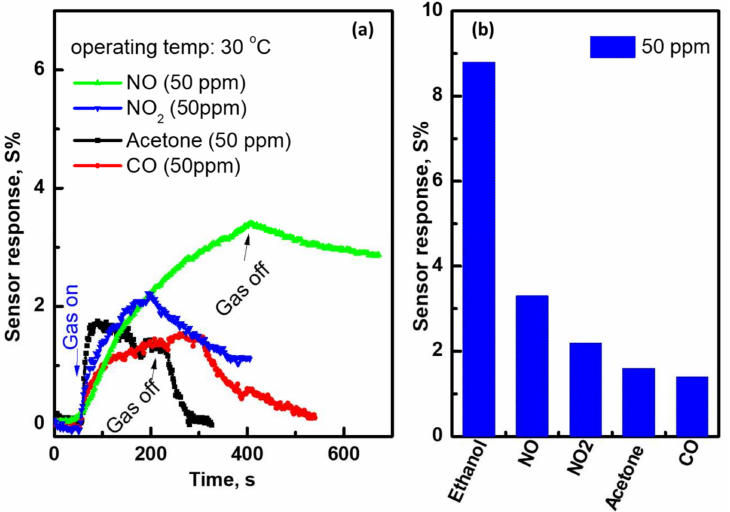
Figure 10. ( a ) Sensor signal toward various gases: NO, NO 2 , acetone, and CO, and ( b ) the sensor’s selectivity toward these gases compared to ethanol measured at 30 ◦ C, for the sensor fabricated with CNTs/24 nm-Ni